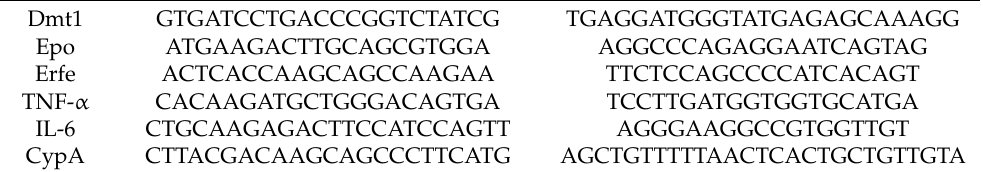
Table 1. qRT-PCR Primer Sequence (5 (cid:48) to 3 (cid:48)